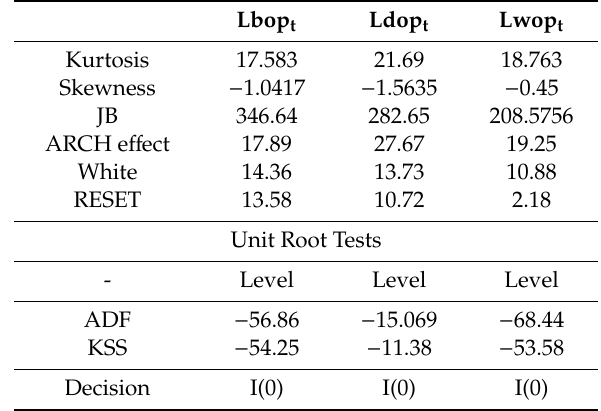
Table 1. Descriptive statistics and unit root tests. lbop t, ldop t and lwop t are the volatilities of the Brent, Dubai and WTI crude oil prices, respectively. ARCH shows the Engle’s [75] ARCH test statistic. White [76] shows White’s heteroscedasticity test statistic, RESET show the RESET statistic, and this test adds the second power of the fitted value as an additional regressor. Lbop t Ldop t Lwop t